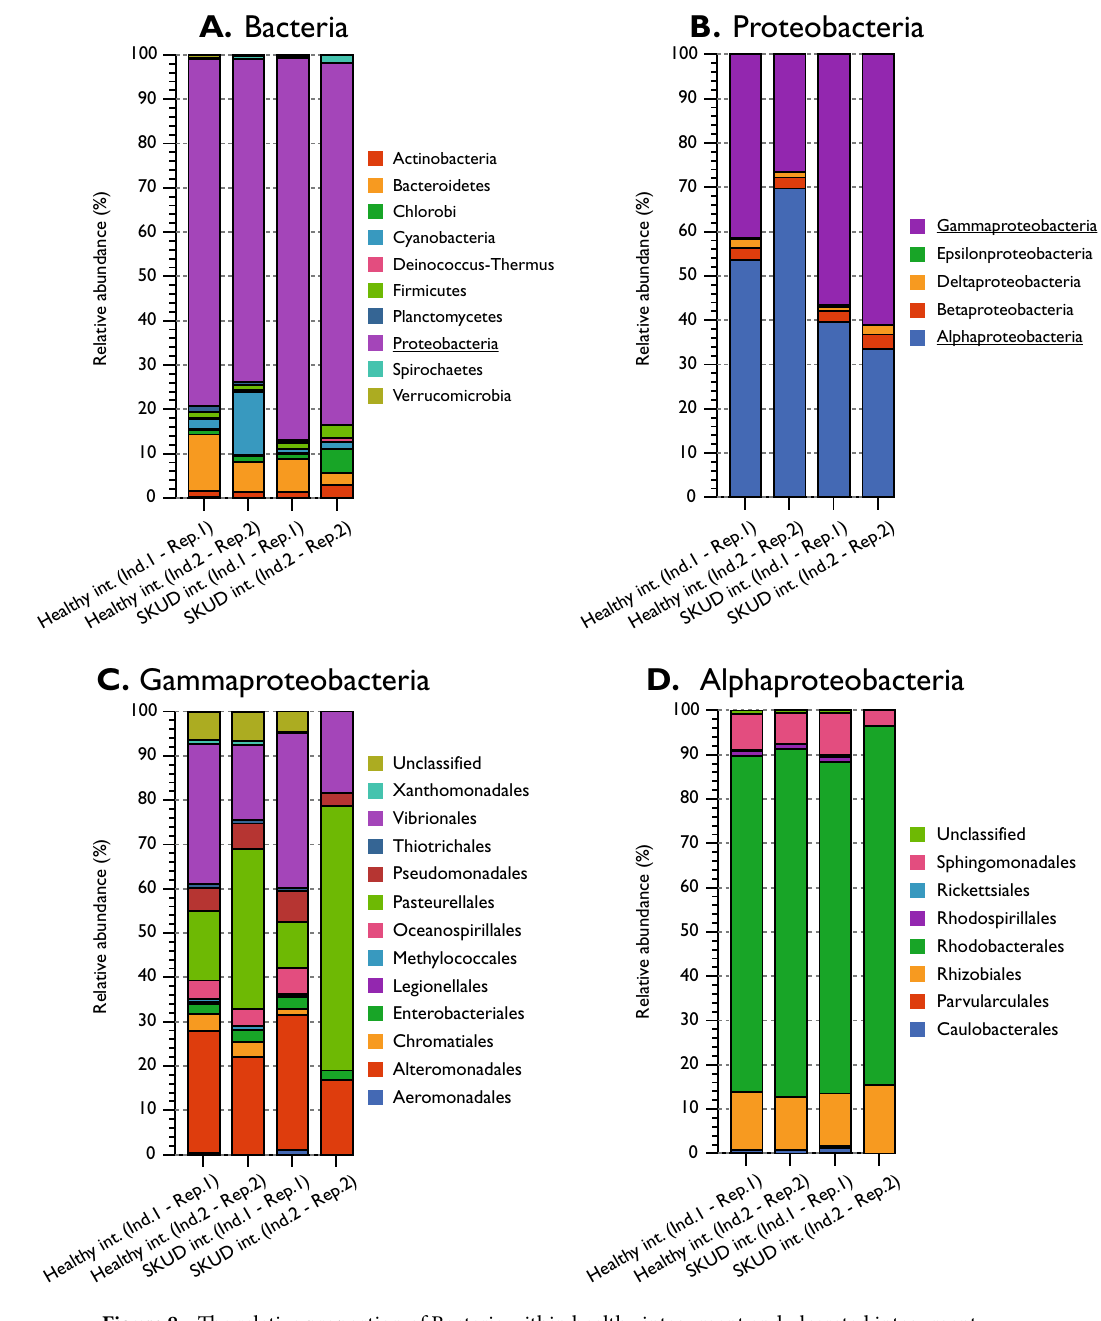
Figure 8. The relative proportion of Bacteria within healthy integument and ulcerated integument of two SKUD-affected Holothuria scabra sea cucumber individuals. ( A ) Bacteria, ( B ) Proteobacteria, Gammaproteobacteria, ( D ) Alphaproteobacteria. (MG-RAST parameter: E-value > e −10 , Percentage Identity > 70%, Alignment length > 15, Minimum Abundance = 50, Representative hits, database: RefSeq). See supplementary Table S1 for statistical